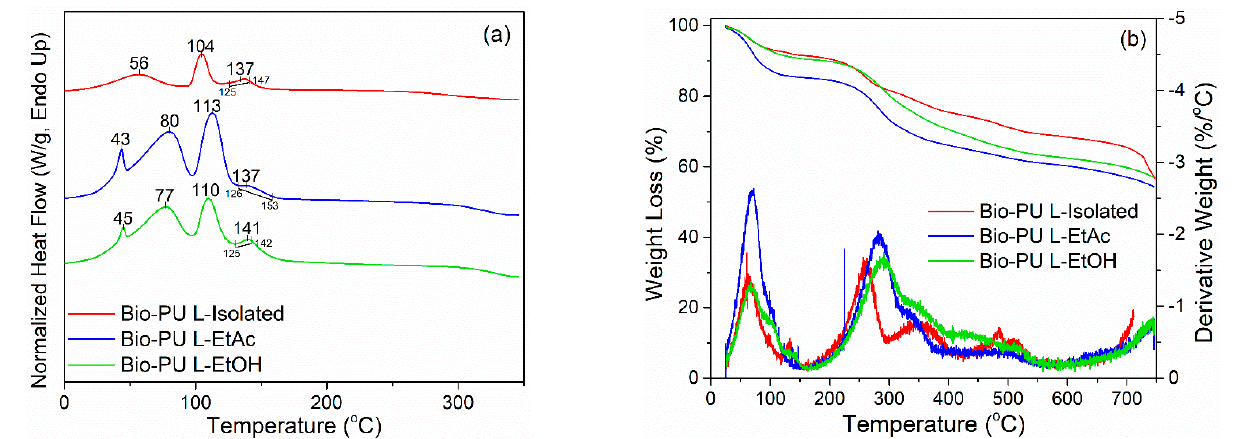
Figure 4. Thermal characteristics of lignin-based bio-PU: ( a ) DSC, ( b ) TGADTG.